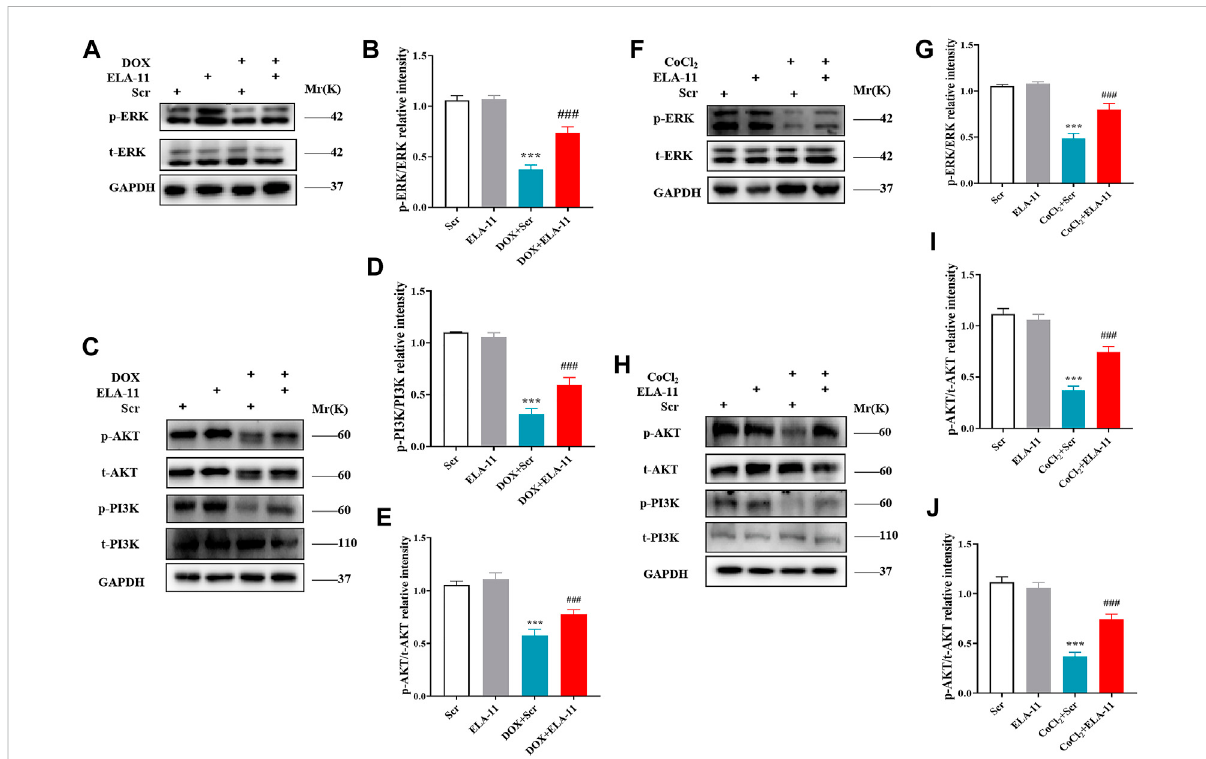
FIGURE 6 ELA-11 attenuatedcardiac injurythrough ERK/MAPK and PI3K/AKT signaling pathway. (A) The expressionof ERK in DOX-induced cardiac injury by western blot. (B) The quantitative data for western blot. (C – E) The expression of PI3K and AKT in DOX-induced cardiac injury by western blot and its quantitative data. (F,G) Western blot analyzed the expression the expression of ERK in CoCl2 -induced cardiac injury and its quantitative data. (H – J) Western blot analyzed the expression the expression of PI3K and AKT in CoCl 0.001 and ### p < 0.001, one-way